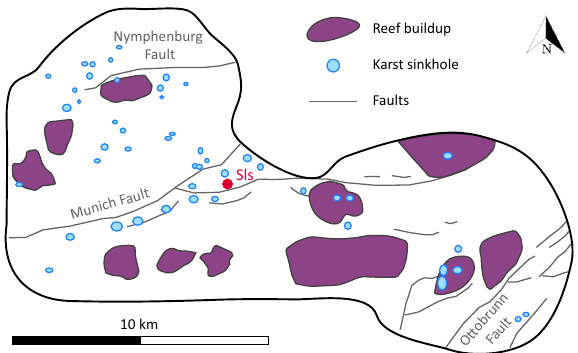
Fig. 15 Distribution of reef buildups and karst sinkholes across the GRAME study area below Munich. Karstification is more intense to the north and larger and better pronounced reef buildups are found in the